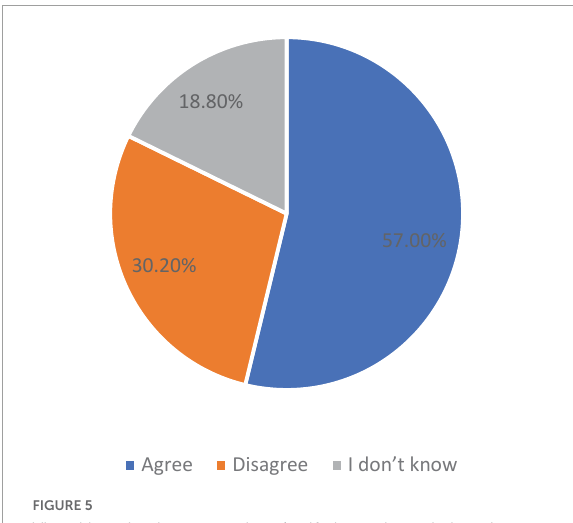
FIGURE5 Virtual learning boosts students’ self-dependency in learning.